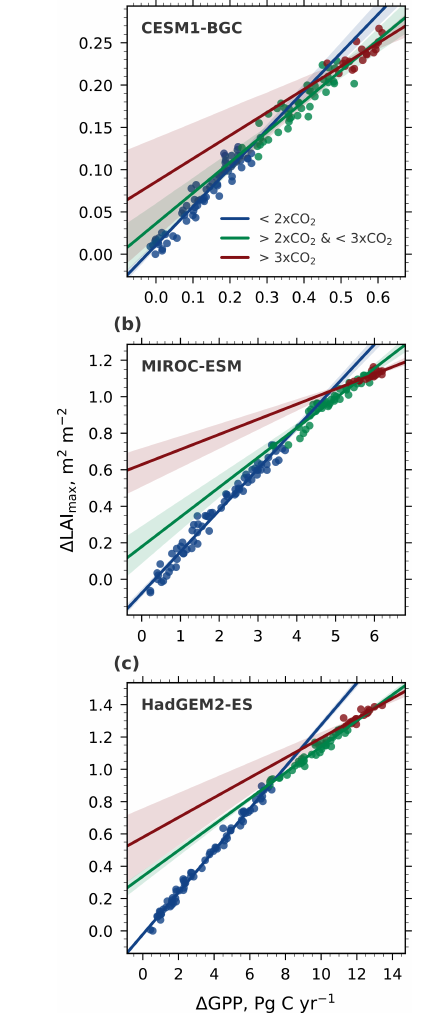
Figure 5. Correlation of (cid:49) LAI max and (cid:49) GPP with increasing CO 2 forcing, starting from a preindustrial concentration of 280ppm (1 × CO 2 ) to 4 × CO 2 (CMIP5 1pctCO2 simulations). Results are shown for three selected CMIP5 models spanning the full range of LAI max sensitivity to ω : low-end: CESM1-BGC (a) , closest to observations: MIROC-ESM (b) , and high-end: HadGEM2-ES (c) . Blue colored dots show the relation between 1 × CO 2 and 2 × CO 2 , green colored dots between 2 × CO 2 and 3 × CO 2 , and red colored dots between 3 × CO 2 and 4 × CO 2 . The respective colored lines represent the best linear fit through those dots and the shading represents the 95% confidence